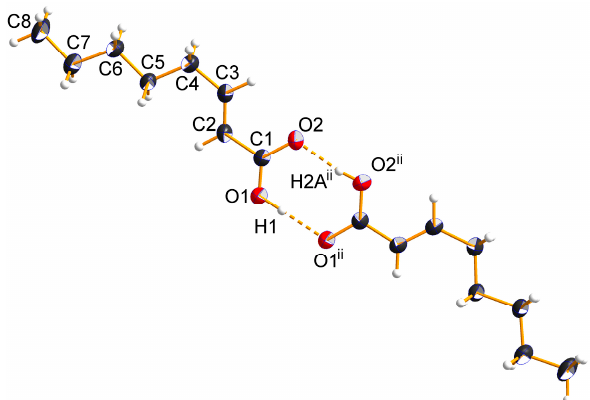
Figure 3. View of acid dimer molecules in the crystal of C8 showing the atom-labeling scheme. Displacement ellipsoids are drawn at the 50% probability level.